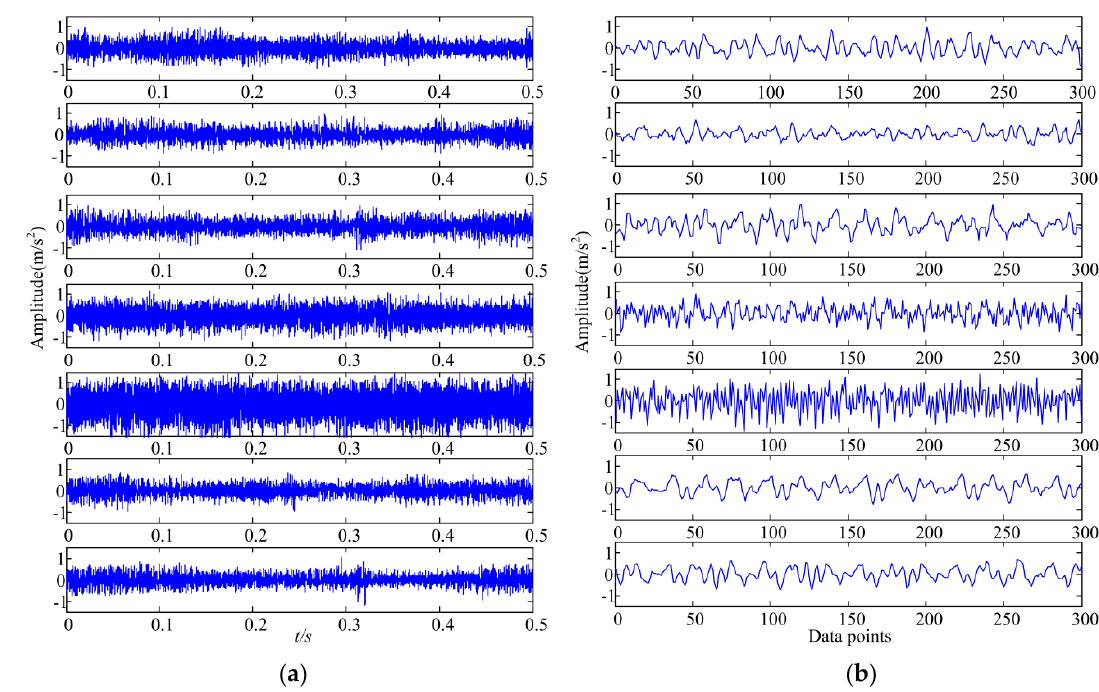
Figure 3. Sample vibration signals of seven gear types in Z -axis under 500 rpm-500 Nm: ( a ) signal with length of 0.5 s, ( b ) signal segment containing 300 data points.